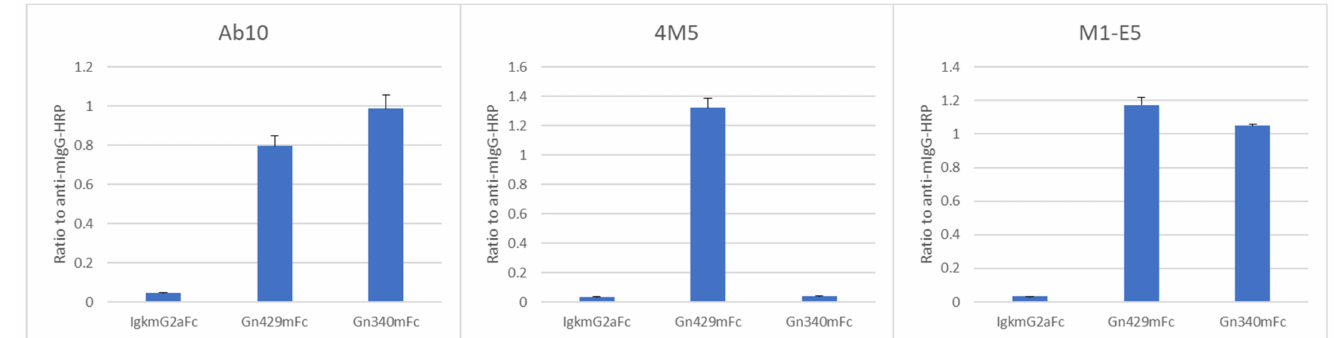
Figure 3. ELISA with truncated Gn proteins. Truncated Gn proteins were detected by anti-mouse IgG labeled with HRP (for normalization) or by biotinylated mAbs with streptavidin HRP. Experiments were performed at triplicates and data are means ± standard deviations of ratios of mAb-absorbance to anti-mouse